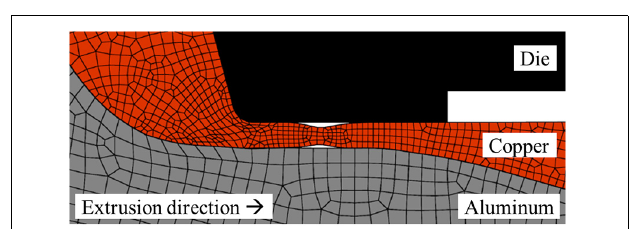
FIGURE 2 | Sleeve necking due to high tensile